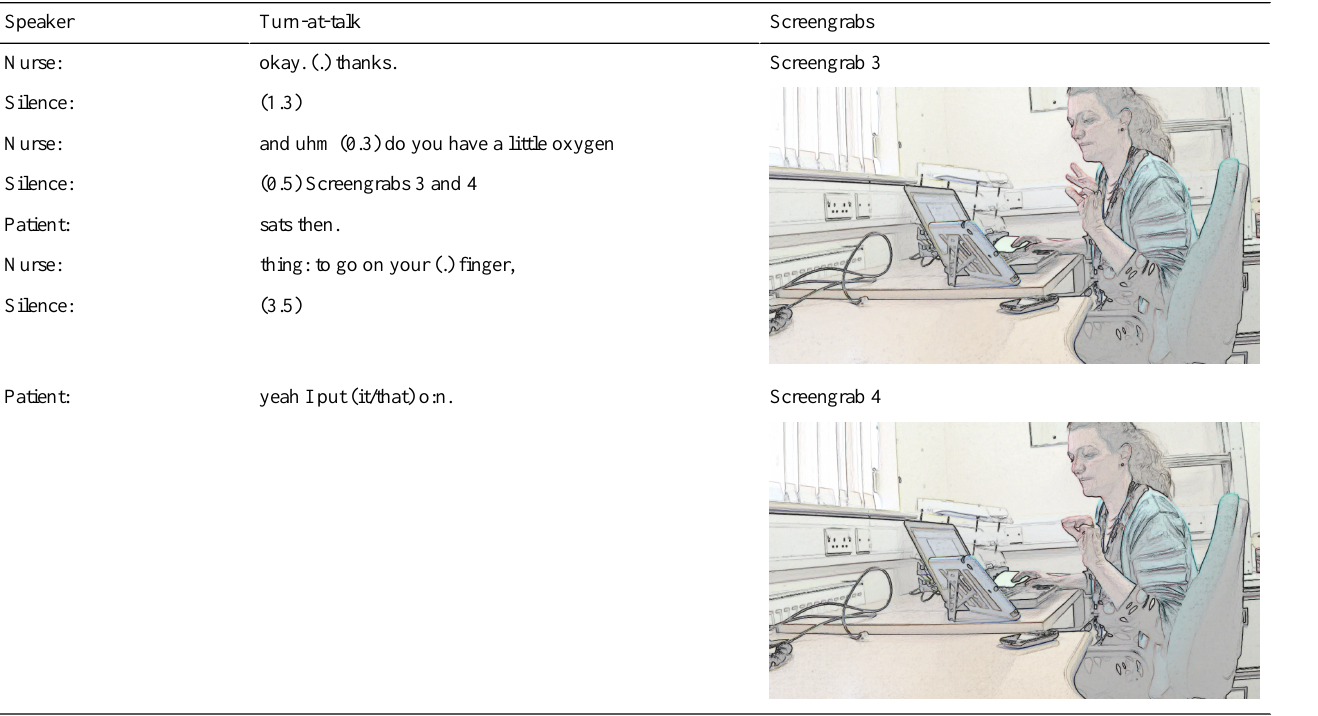
Screengrab 3okay. (.)